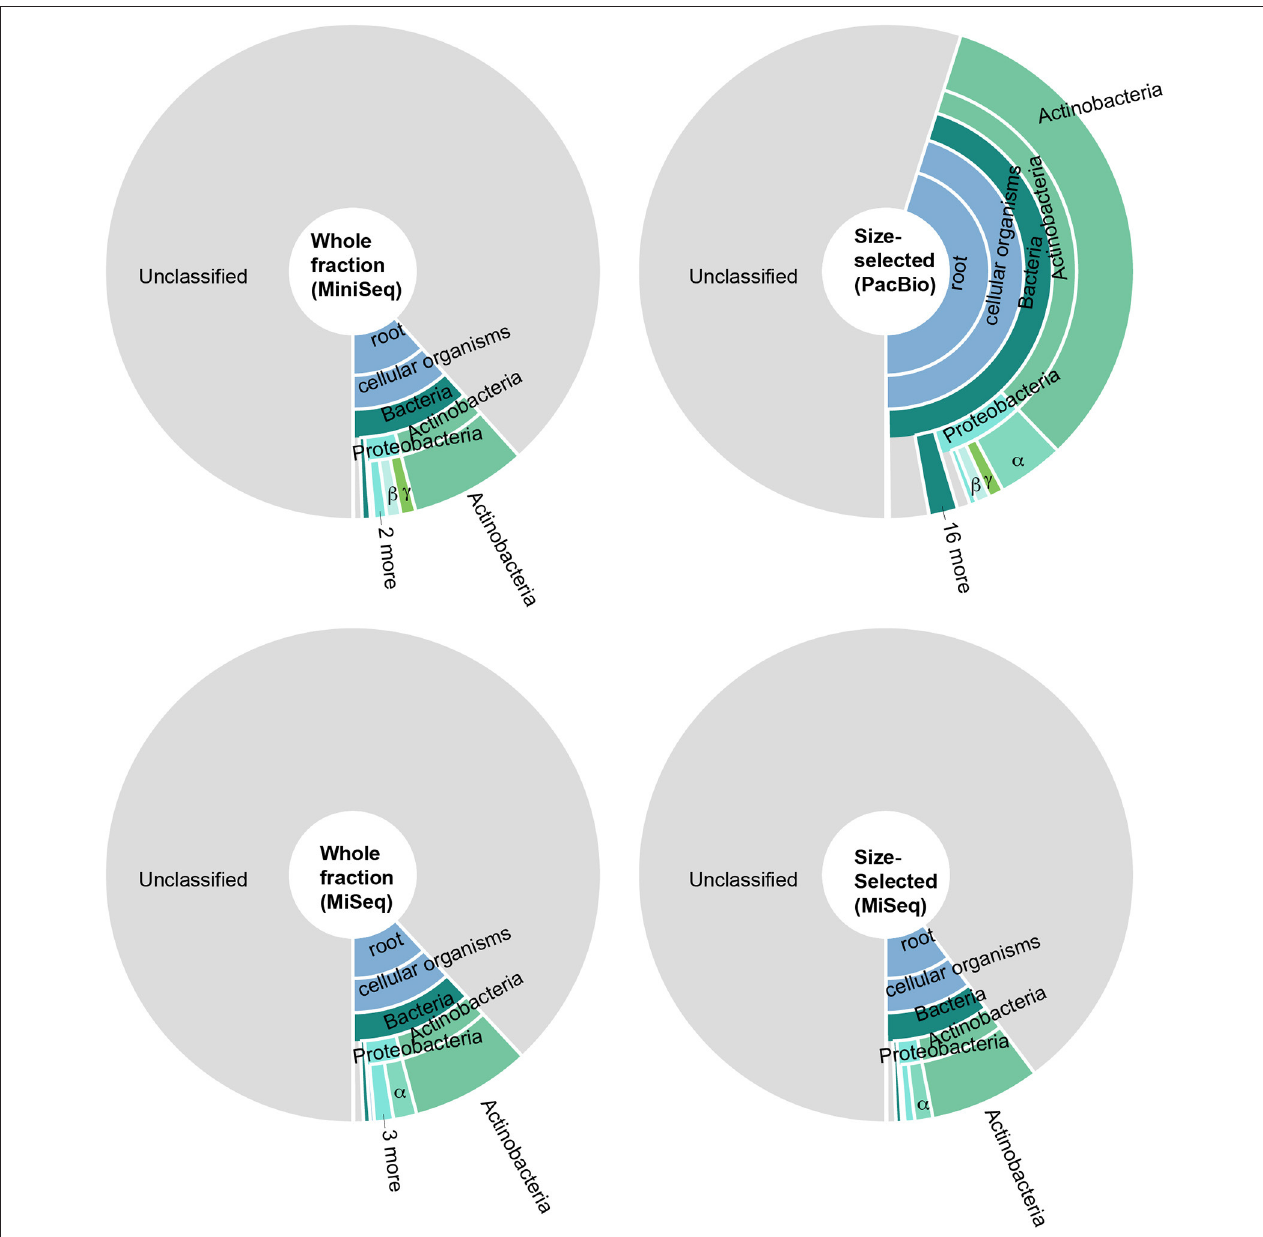
FIGURE 4 | Taxonomic distribution of predicted open reading frames in metagenomic data generated by sequencing (i) the whole DNA fraction on an Illumina MiniSeq (top left), (ii) size-selected fraction on the PacBio system (top right), (iii) whole DNA fraction on an Illumina MiSeq (bottom left), and (iv) the size-selected fraction on an Illumina MiSeq (bottom right). In all cases, most predicted genes could not be assigned to any taxonomy; of the genes that could be assigned, most were Actinobacteria and Proteobacteria. Colors are the same